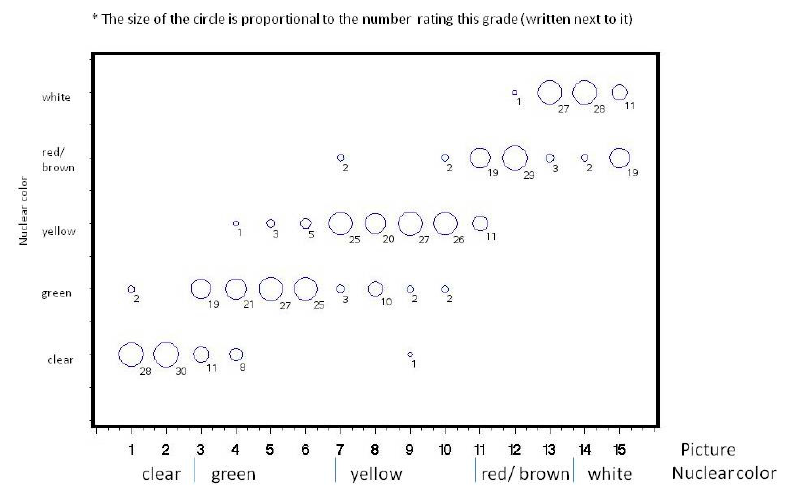
Figure 4. Distribution of 30 ophthalmologists’ grading when grouped according to nuclear color for the 15 photographs at Time 1.